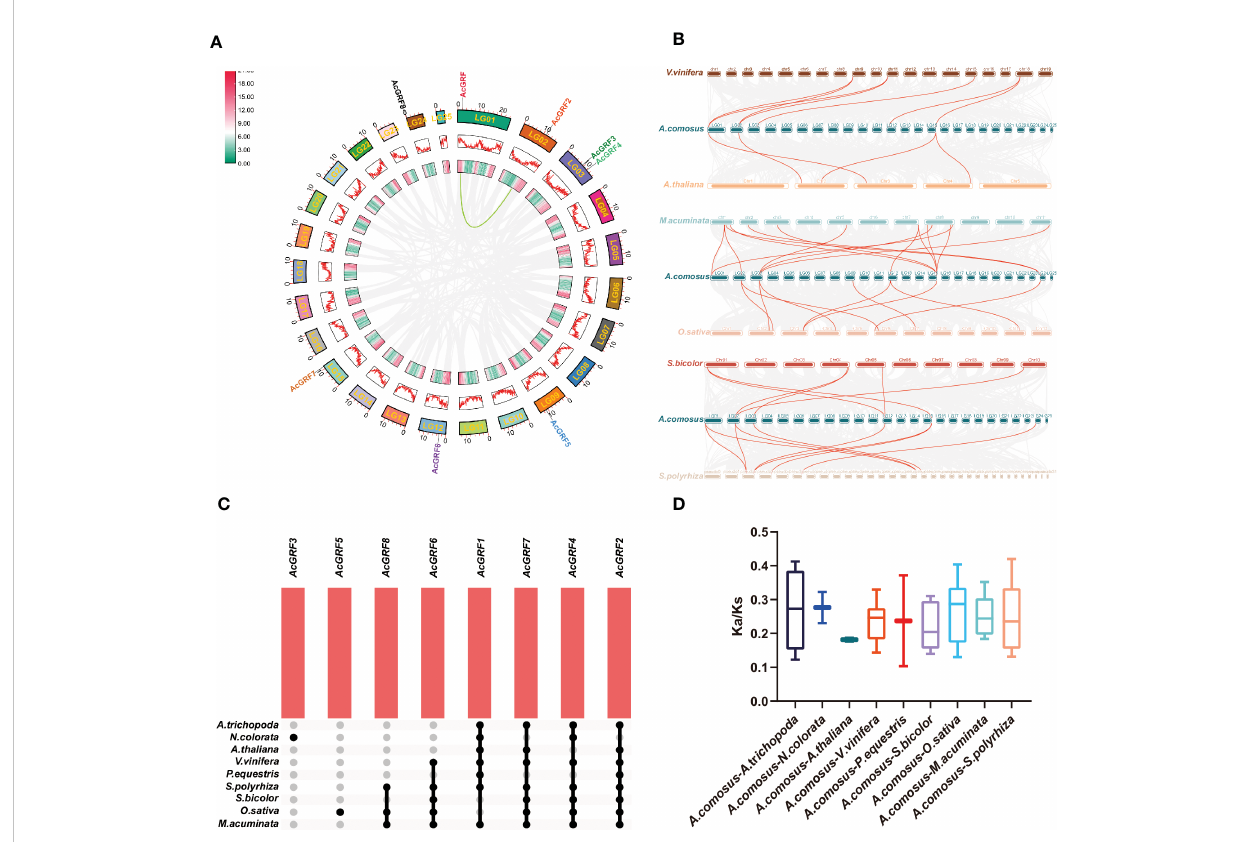
FIGURE 3 Collinearity and Ka/Ks analyses of pineapple AcGRFs and their homologs in other species. (A) Circos plot of pineapple collinear homologous genes. Genome-wide collinear blocks are set against a gray background, and duplicate AcGRF gene pairs are highlighted by red and green curves. Each pineapple chromosome is accompanied by 100 kb of gene density information, depicted by heat maps and waveform maps. (B) Collinearity of GRF genes in pineapple and six representative species. Same-line blocks are set to a gray background, and collinear GRF genes are highlighted with red curves. (C) Venn diagram of non-redundant collinear GRF genes in pineapple and other species. (D) Box plot of Ka/Ks ratios of GRF